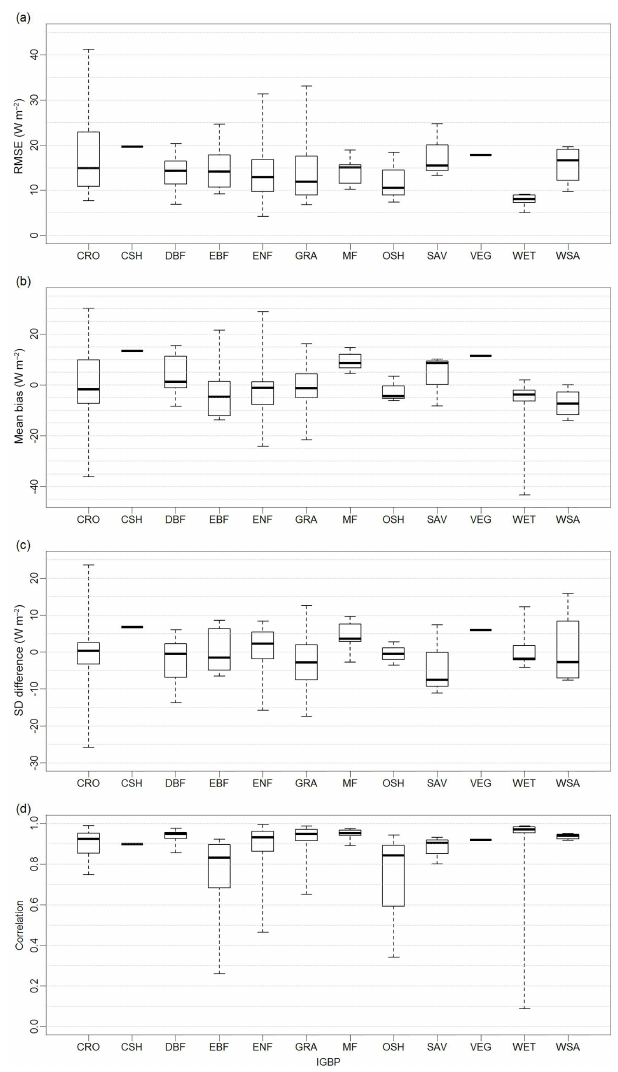
Figure 9. Four statistics – (a) RMSE, (b) mean bias, (c) SD differ- ence and (d) correlation – calculated for DOLCE at 142 flux tower sites and displayed by biome types. See Fig. 2 for biome abbrevia-